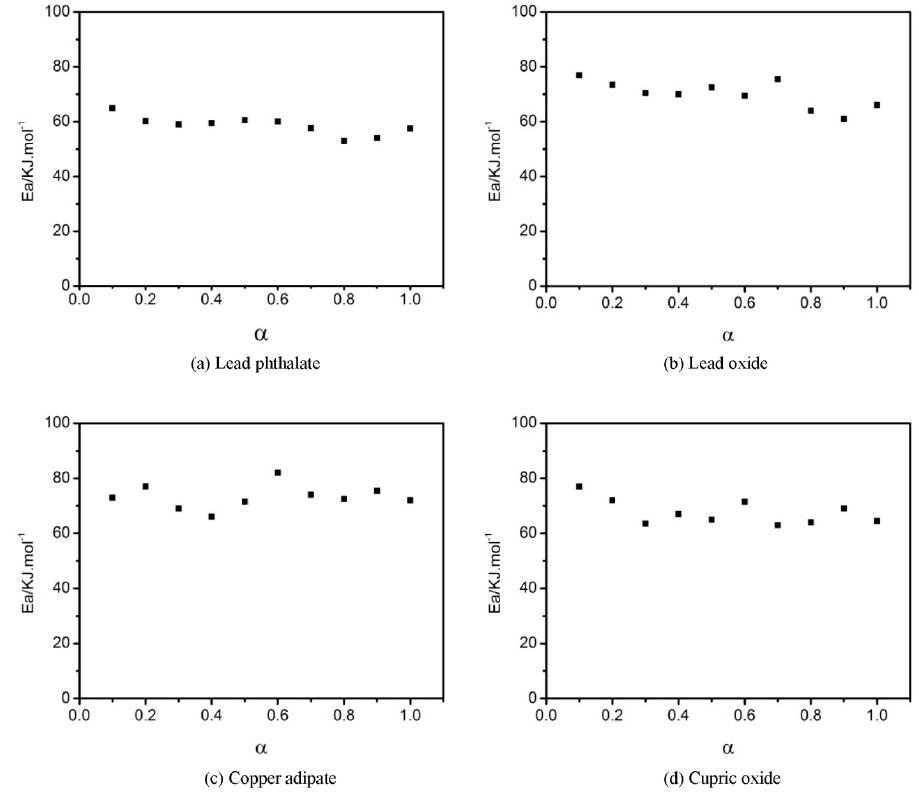
Figure 9. The relationship between the activation energy and conversion rate of Figure9. The relationship between the activation energy and conversion rate of GAPSPs.